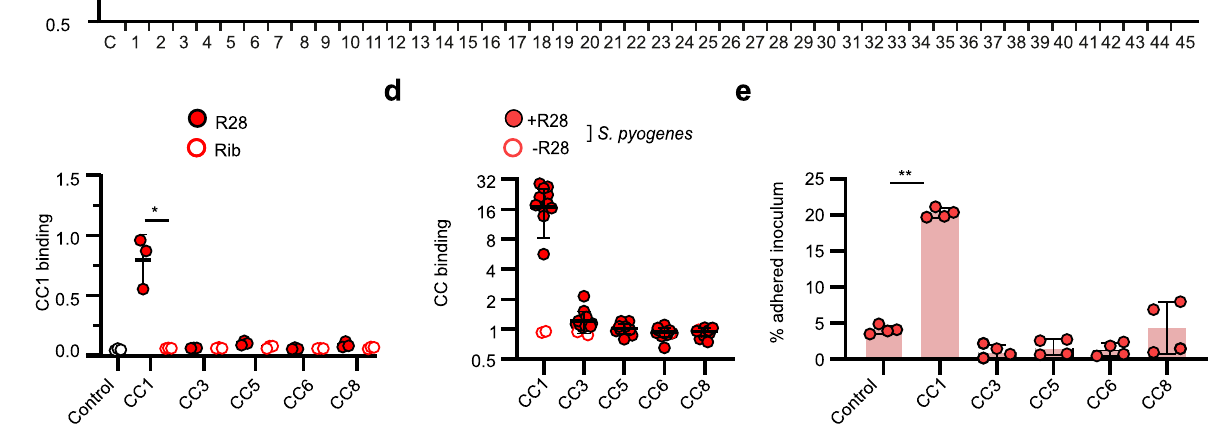
Fig.2|CEACAM1isahighlyspeci fi creceptorfortheR28adhesin.a Schematicof screening procedure for a library of 3359 HEK293 (Supplementary Data 1) cell line clones expressing human membrane proteins for ability to bind the streptococcal proteins R28and Rib. Positive signalswereobtainedwith45celllines. b Binding of puri fi ed R28 protein to the 45 positively-hit HEK293 cell lines. Cells stained with rabbit anti-Rib sera (red) or normal rabbit sera (black) are shown. The relative fl uorescence means±s.d. of n =4 from two independent experiments is shown. A representative image of fl uorescence for the 45 cell lines (tested in duplicates) is shown in the inset, with FCGR1 identi fi ed as a non-speci fi c hit. c Binding of recombinant CEACAM1-HIS (CC1), CEACAM3-HIS (CC3), CEACAM5-HIS (CC5), CEACAM6-HIS (CC6), and CEACAM8-HIS (CC8) to immobilized R28 and Rib